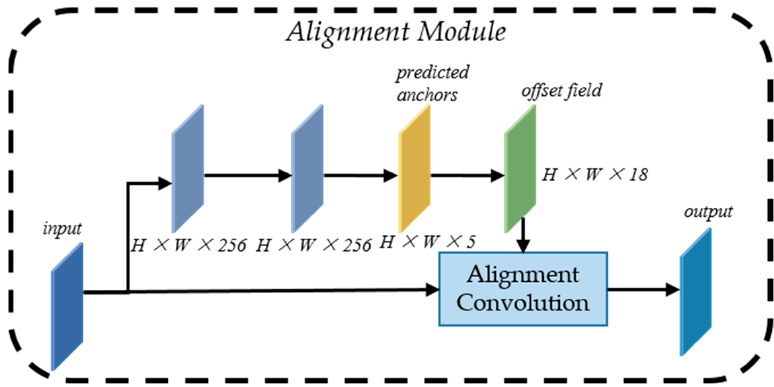
Figure 8. Architecture of anchor-guided feature alignment network (AFAN).